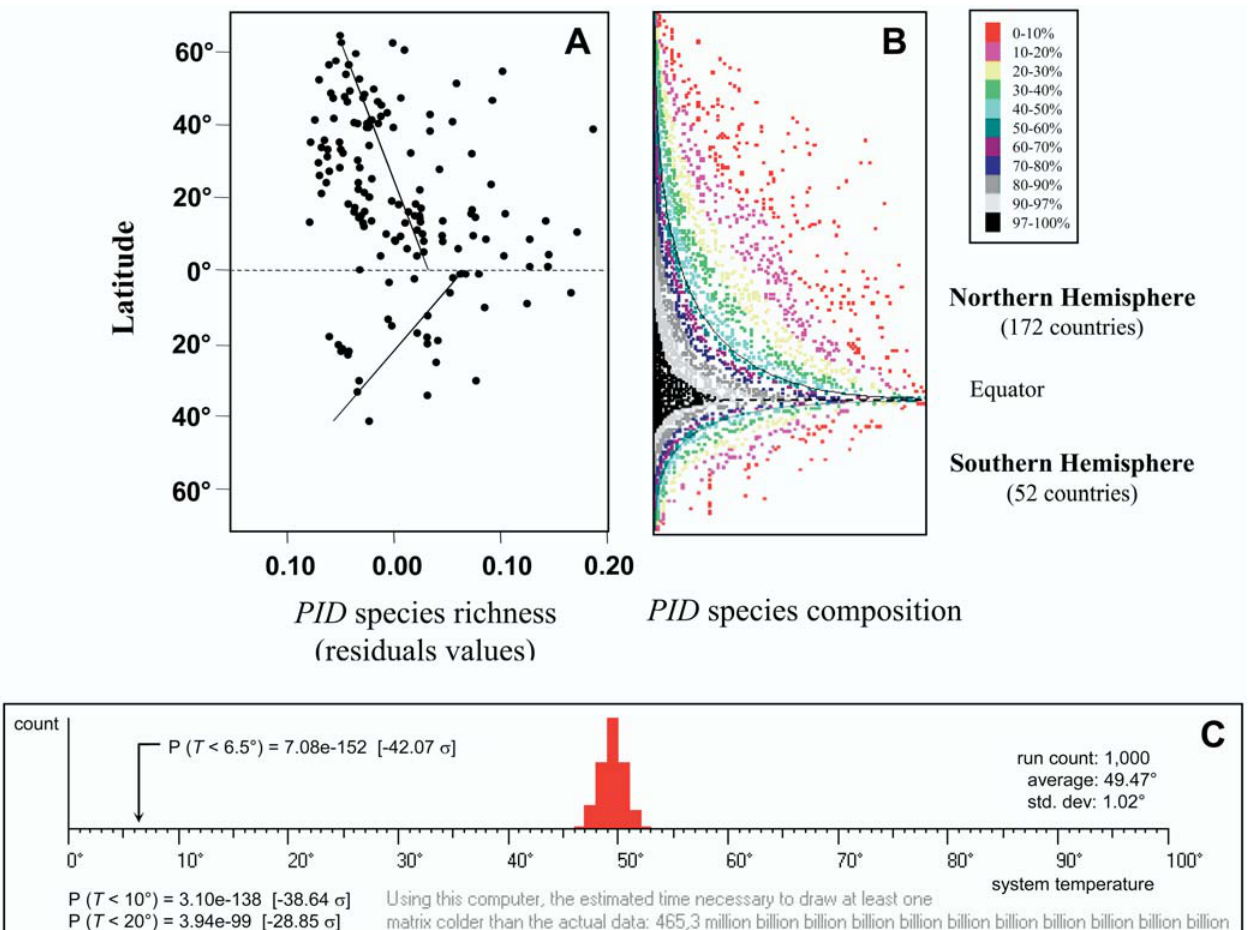
Figure 2. The Latitudinal Gradients of PID Species (A) Relationship between PID species richness and latitude across the two hemispheres. Linear relationships between PID species richness and latitude (dotted lines) are highly significant ( F = 12.29, df = 29, p = 0.0015 and F = 18.01, df = 130, p , 0.0001 for Southern and Northern hemispheres, respectively). No difference in disease species richness with latitude across the two hemispheres was observed (interaction: F = 2.68, df = 159 , p = 0.1036). Residuals of PID species richness on the y axis were extracted from minimal models controlling for the effects of confounding factors on PID species diversity estimates (see Materials and Methods). Locally weighted regression (tension 0.5) did not change the general linear shape. Latitude is expressed in minute degrees. (B) Presence/absence matrix for the 229 distinct PID species across the hemispheres. The figure was generated by the Nestedness Temperature Calculator (see Atmar and Patterson 1995). The distribution is nonsymetrical because of the 224 studied countries, 172 countries are found in the Northern hemisphere versus only 52 in the Southern one. (B) indicates that PID species diversity decreases as one moves northwards or southwards from the equator. The black exponential curves are the occurrence boundary lines (see Materials and Methods). The color scale indicates the nonuniform probability of state occupancy among all of the cells of the matrix, i.e., the probability of encountering a species as function of its position in the matrix. Black cells are highly predictable presences, whereas red cells are unexpected presences. (C) Monte Carlo–derived histogram after 1,000 permutations. The histogram represents the 1,000 values obtained after Monte Carlo permutations. The average theoretical value under the null hypothesis is compared to our real value, to assess the likelihood that the parent matrix was nonrandomly generated. The probability is highly significant ( p , 0.0001), confirming that the spatial organization of PID species richness on the largest scale matches the nested species subset hierarchy illustrated in Figure 1A. The symmetrical Gaussian distribution indicates that 1,000 permutations are enough to obtain reliable variance estimates for probability calculations. DOI: 10.1371/journal.pbio.0020141.g001